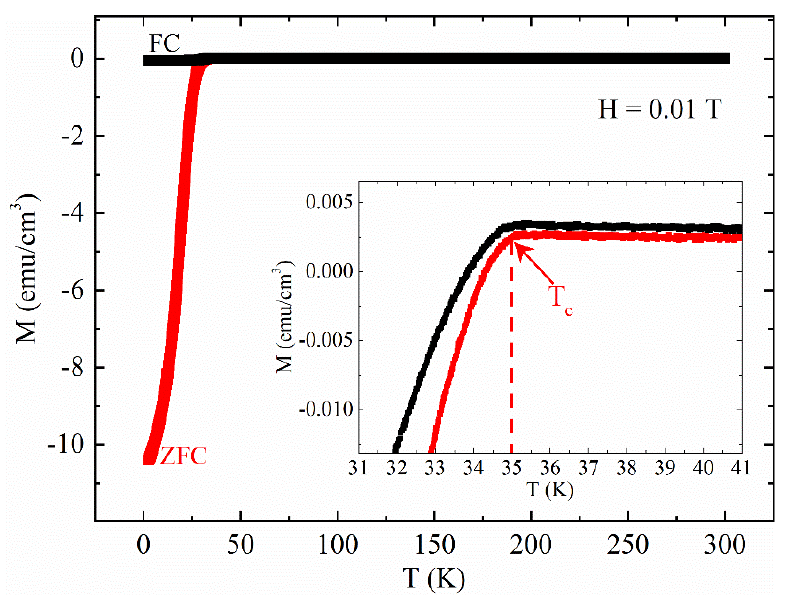
Figure 1. Magnetization versus temperature M(T) measured in ZFC-FC conditions at H = 0.01 T. Inset: T c is indicated by a red arrow.